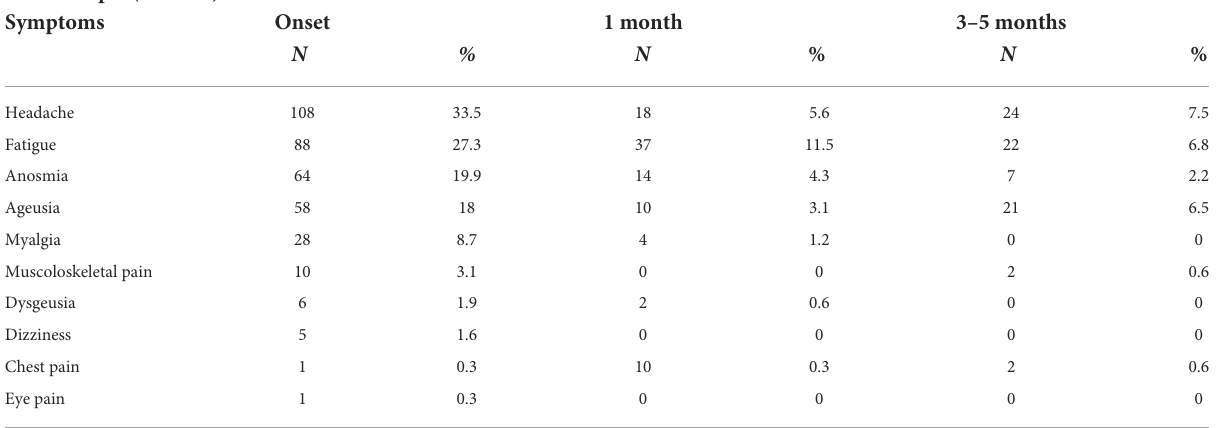
TABLE 1 Symptom course in COVID-19-positive paediatric patients. Total sample ( n =